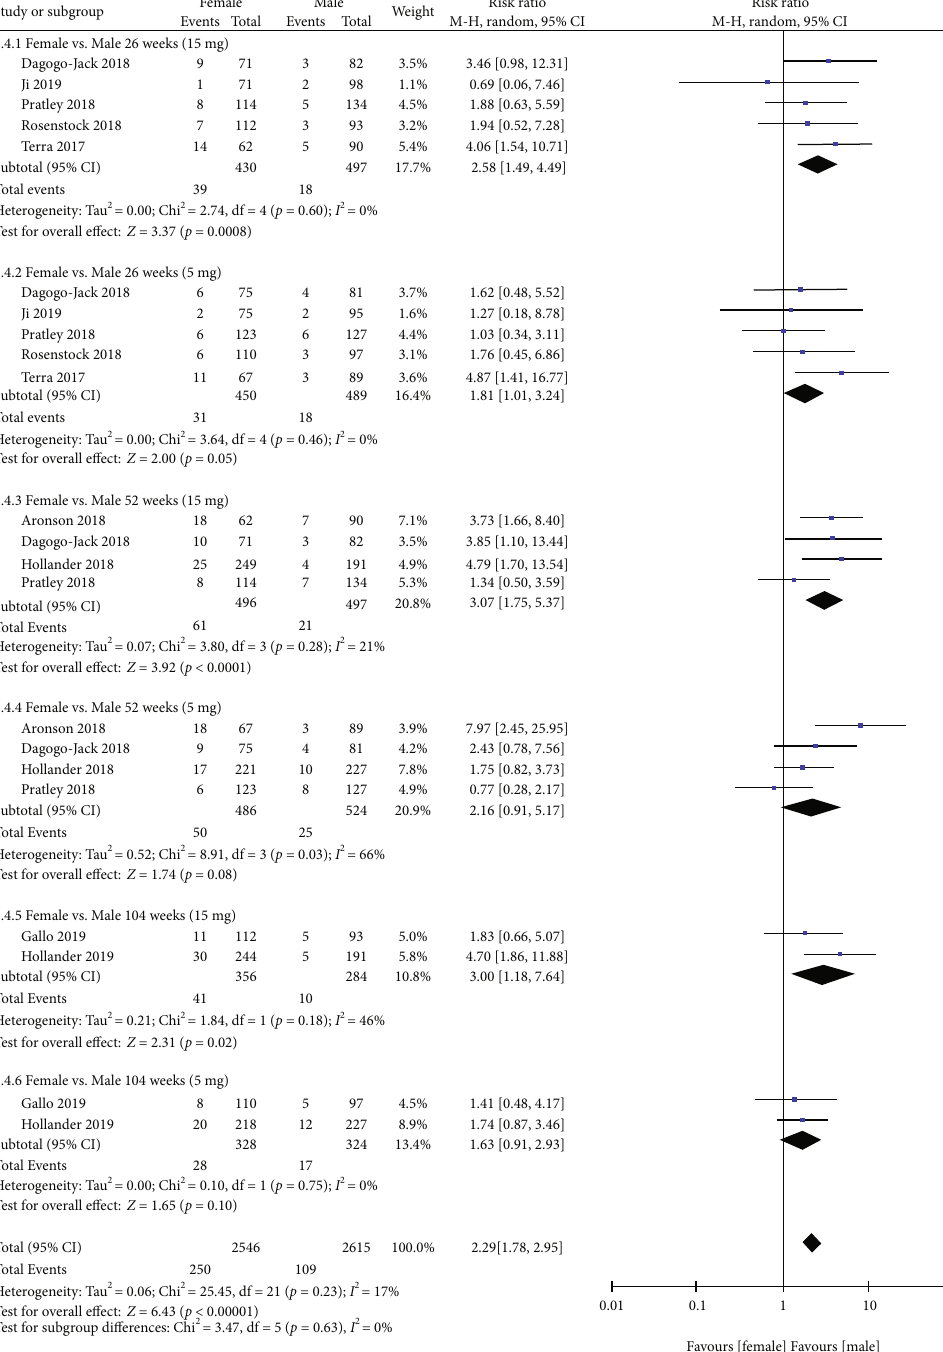
Figure 6: Forest plot of the risk of GMIs when comparing females with males at 26, 52, and 104 weeks. CI: con fi dence interval; M-H: Mantel-